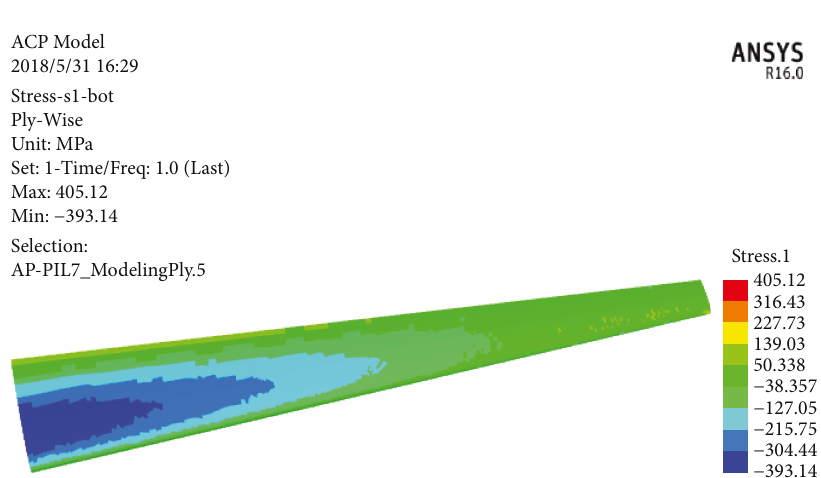
Figure 18: Stress cloud diagram of the upper wing with the layer sequence being [0/45/90/-45/0]